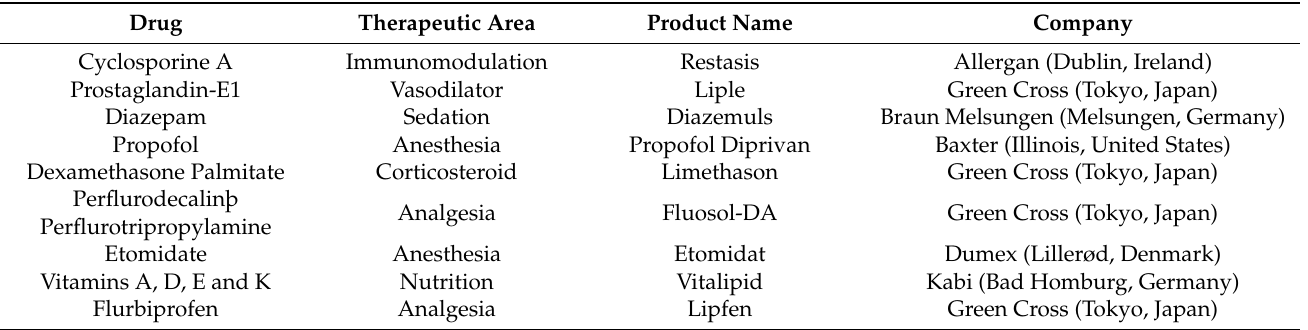
Table 7. Marketed parenteral microemulsion